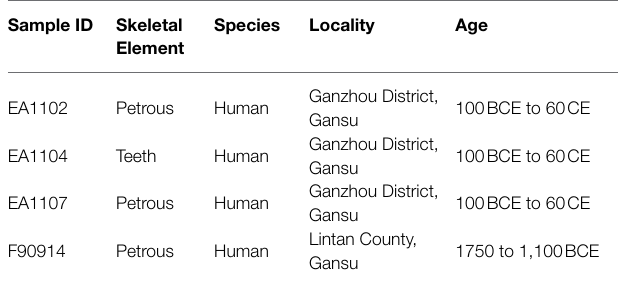
TABLE 1 | Samples from which aDNA was extracted. EA1102, EA1104, and EA1107 are three samples from different individuals. Sample ID Skeletal